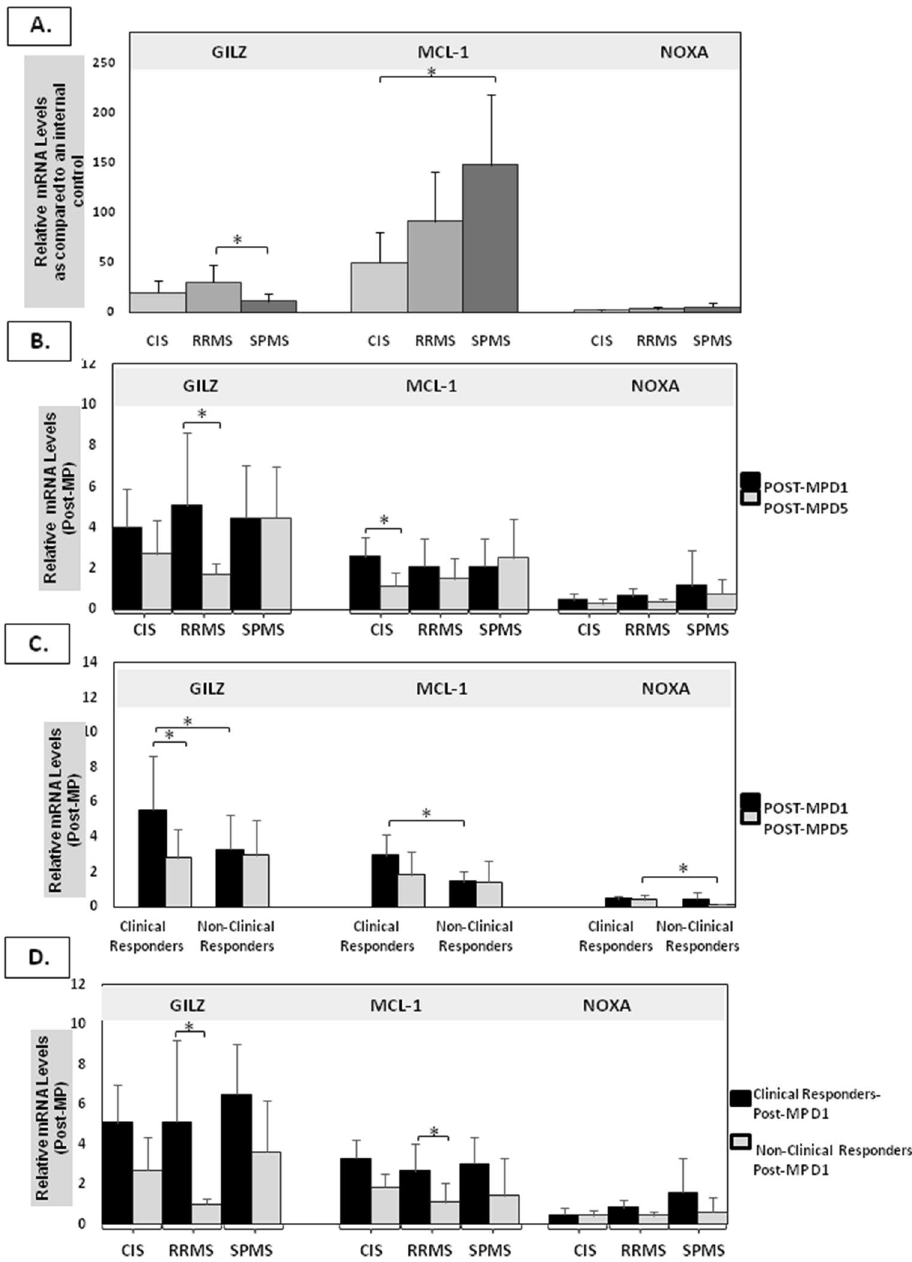
Figure 1. mRNA expression levels of GILZ, MCL-1 and NOXA genes. ( A ) Relative basal expression of GILZ, MCL-1 and NOXA in different MS subtypes before MP treatment on Day 1 acquired by RT ‐ qPCR. GILZ basal mRNA levels were significantly lower in SPMS (n = 12) as compared to RRMS (n = 12) group ( p < 0.05) while MCL-1 mRNA levels was significantly induced in SPMS group as compared to CIS (n = 15) ( p < 0.05). (n = sample size). ( B ) Relative expression of GILZ, MCL-1 and NOXA in different MS subtypes after MP treatment on Day 1 and Day 5 acquired by RT ‐ qPCR. GILZ and NOXA mRNA levels were significantly lower in RRMS (n = 12) after the 5th MP treatment as compared to values measured 1 h after the 1st MP treatment ( p < 0.05). MCL-1 mRNA levels was also significantly reduced in CIS group 1 h after the 5th MP treatment as compared to values measured after the first MP treatment ( p < 0.05). ( C ) GILZ and MCL-1 mRNA levels were significantly higher in clinical responders (n = 25) as compared to non- clinical responders (n = 14) after the 1st MP treatment. Moreover, the GILZ mRNA levels were significantly lower in clinical responders on Day 5 after 5th MP treatment as compared to values measured on Day 1. (n = sample size). ( D ) GILZ and MCL-1 mRNA levels were significantly higher in RRMS clinical responders (n = 9) one hour after the first MP injection as compared to non-clinical responders (n = 3) of the same group one hour after the 1st injection ( p < 0.05). Data are shown as mean ± SD (* P < 0.05). (n = sample